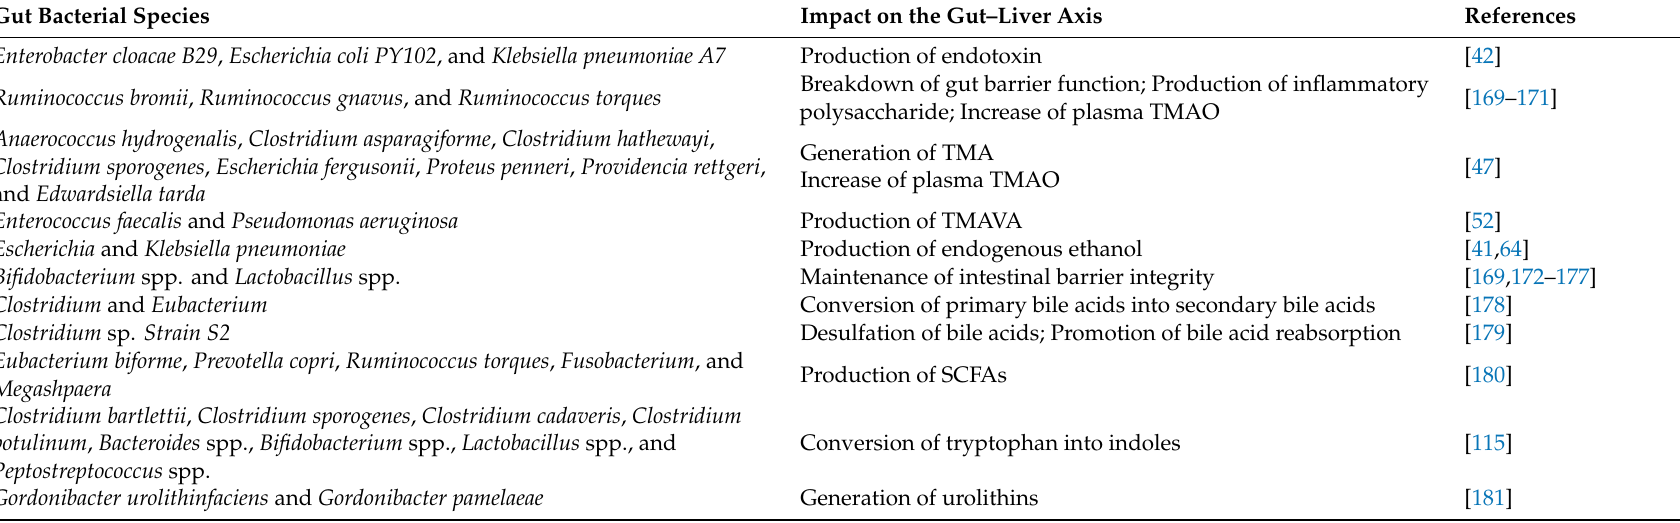
Table 1. The gut bacterial species that exhibit an impact on the gut–liver